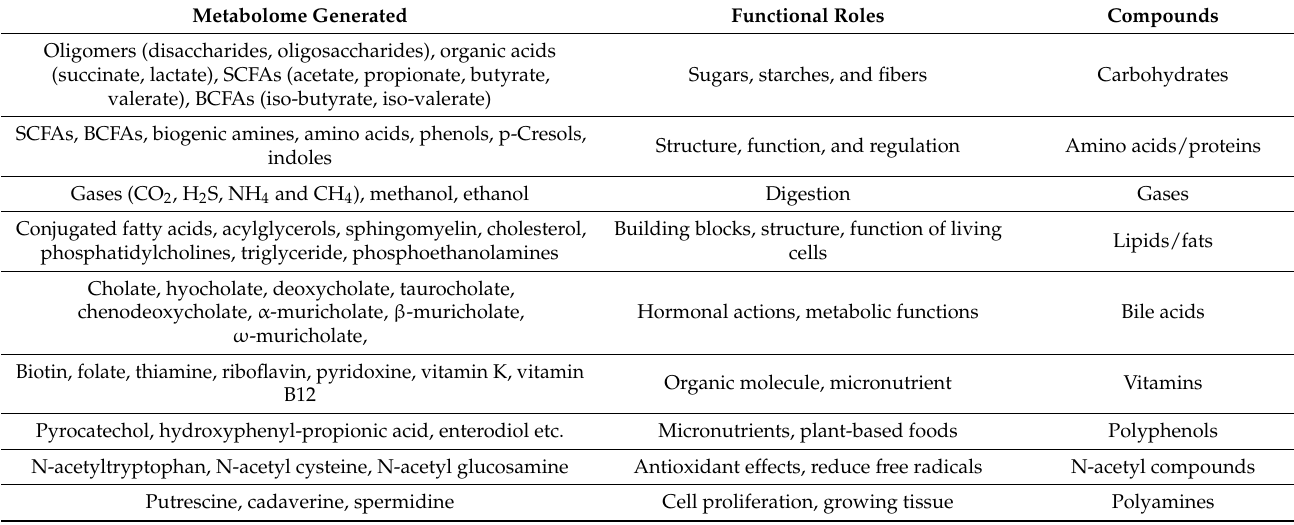
Table 2. Metabolome, organic compounds, and gases in liver metabolisms and microbial fermentation. Metabolome Generated Functional Roles Compounds Sugars, starches, and fibers Carbohydrates